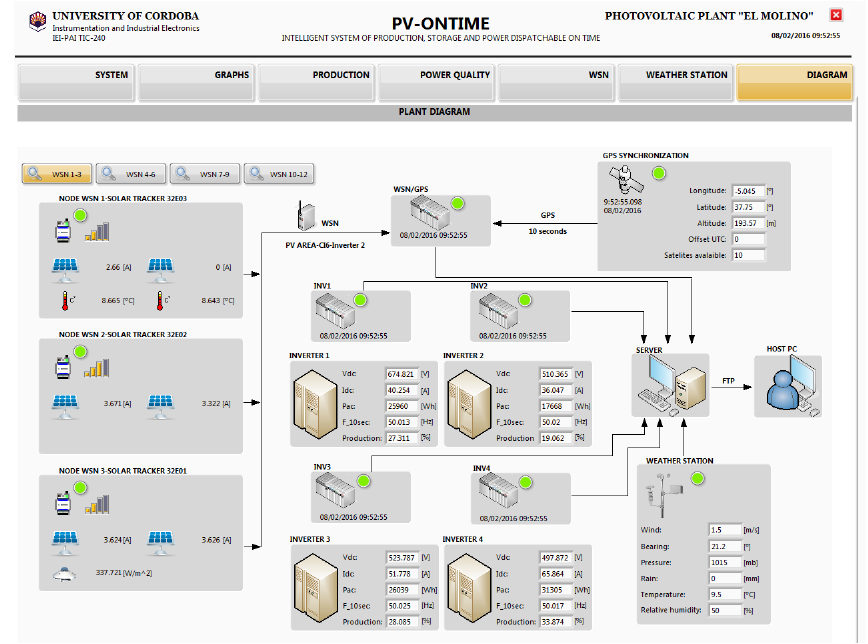
Figure 17. Monitoring application for supervising the PV-on time